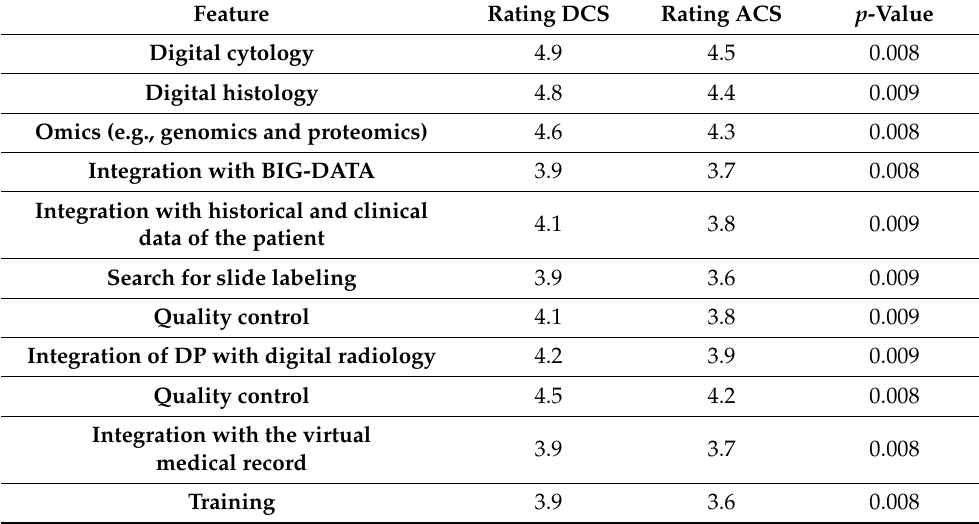
Table 3. Detailed answers in the Likert scale to the question of “In which specific sectors of biomedical diagnostics do you think the introduction of artificial intelligence is most